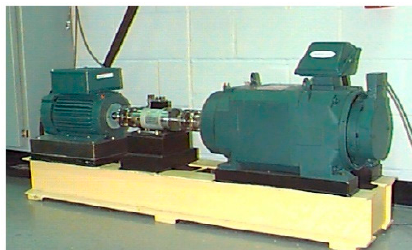
Figure 3. Schematic diagram of rolling-element-bearing fault-simulation experiment (Case I).